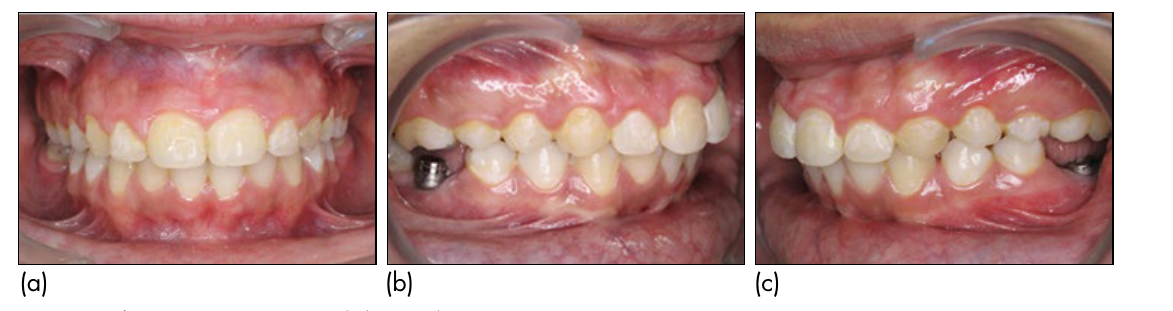
Figure 6 (a, b, c). Post-treatment intra-oral